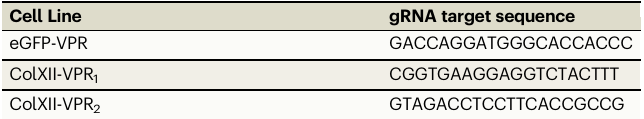
Table 1 | gRNAs used to generate Col12a1 overexpressing cell lines Cell